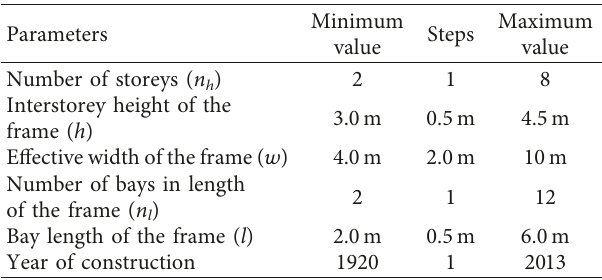
Figure 5: Distribution of 46 building samples across the Campania region. Table 2: Assumed intervals for the adopted parameters of building